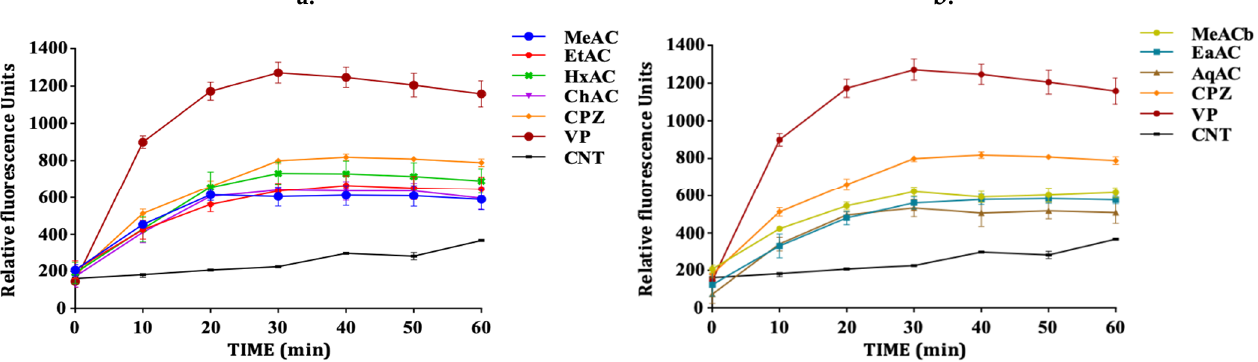
Figure 4. Effect of A. cepa on the accumulation of EtBr in S. aureus. ( a ) A. cepa pink: MeAC-methanol, EtAC-ethanol, HxAC-hexane and ChAC-chloroform; ( b ) Allium cepa white: MeACb-methanol, EaAC-ethanol, AqAC-aqueous, CPZ— chlorpromazine; VP-verapamil; CNT-control.